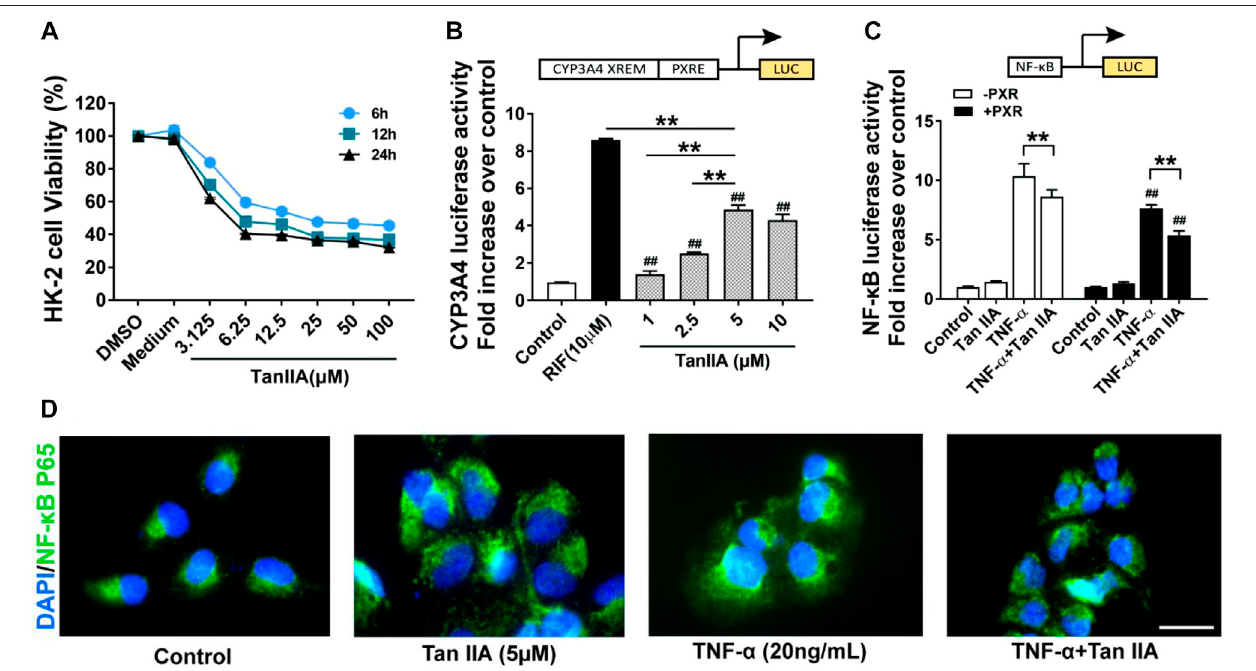
FIGURE 6 | Effects of TanIIA in human PXR activation and human PXR-mediated NF- κ B repression. (A) Cell viability assay of TanIIA on HK-2 cells; (B) TanIIA on PXR-mediatedCYP3A4transcriptionalreporterassay.RIF=10 µM **p < 0.01comparedwithindicatedgroups. ##p < 0.01comparedwiththecontrolgroup. (C) TanIIA on PXR-mediated NF- κ B repression reporter assay. HK-2 cells were transfected with/without hPXR small-interfering RNA (siRNA). All cells were transfected with NF- κ B luciferase reporter plasmid. HK-2 cells were stimulated by TNF- α (20 ng/ml) to activate NF- κ B signaling. **p < 0.01 compared between two groups. # #p < 0.01 compared with TNF- α -stimulated cells without human PXR plasmid transfection. (D) Immuno fl uorescence staining images were captured by a fl uorescence microscope.Datawererepresentedasmean±SEM,Student ’ s t -testwasusedforpaireddata.One-wayANOVAfollowedbyTurkey ’ stestformultiplecomparisonswas used for three or more groups. Scale bar, 25 μ m; abbreviations: DMSO, dimethyl sulfoxide; P65, NF- κ B p65; RIF, rifampin; TNF- α , tumor necrosis factor α .